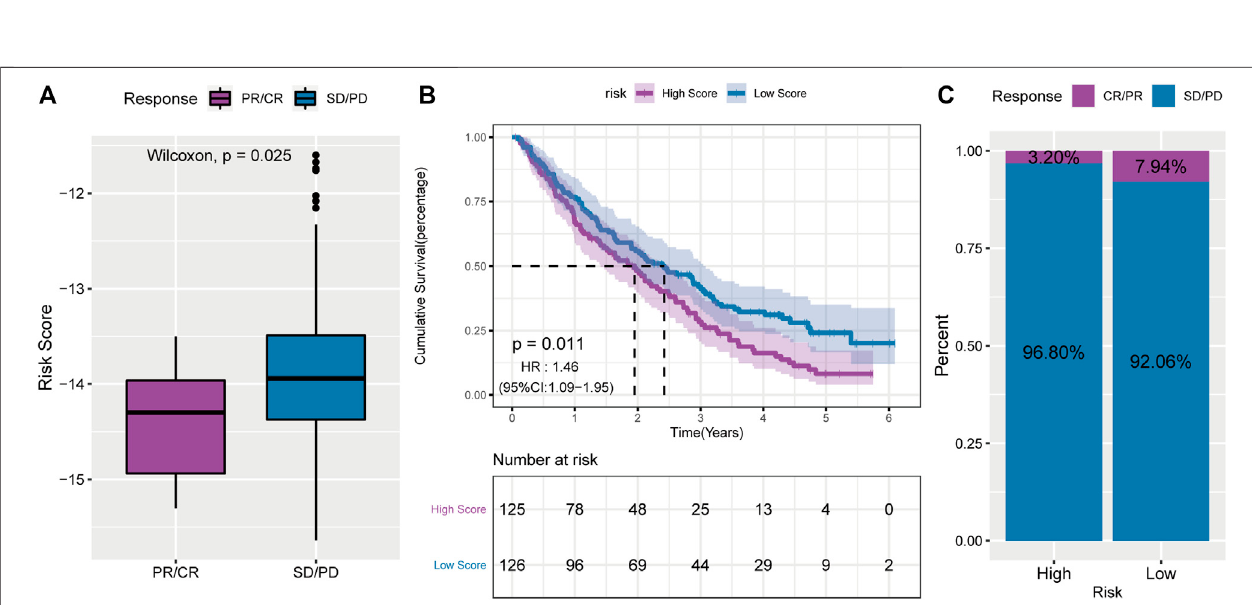
FIGURE 10 | Relationship between tumor risk score and immune cell in fi ltration. (A) : Heat map of the distribution of immune cell in fi ltration ratio; (B) : difference of ESTIMATE Score; (C) : difference of Immune Score; (D) : difference of Stromal Score; (E) : difference of tumor purity; (F) : GSVA analysis of differentially expressed